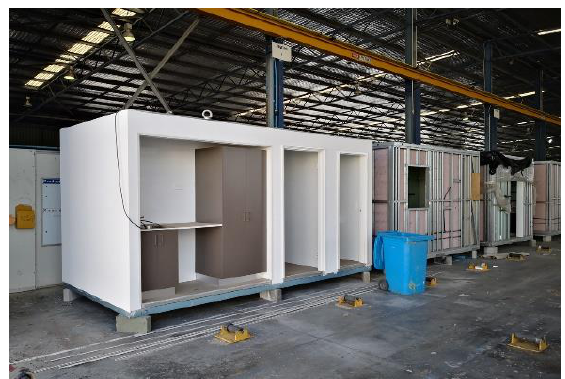
Figure 3. Module manufacture at workshop (photo by Y. Sun).